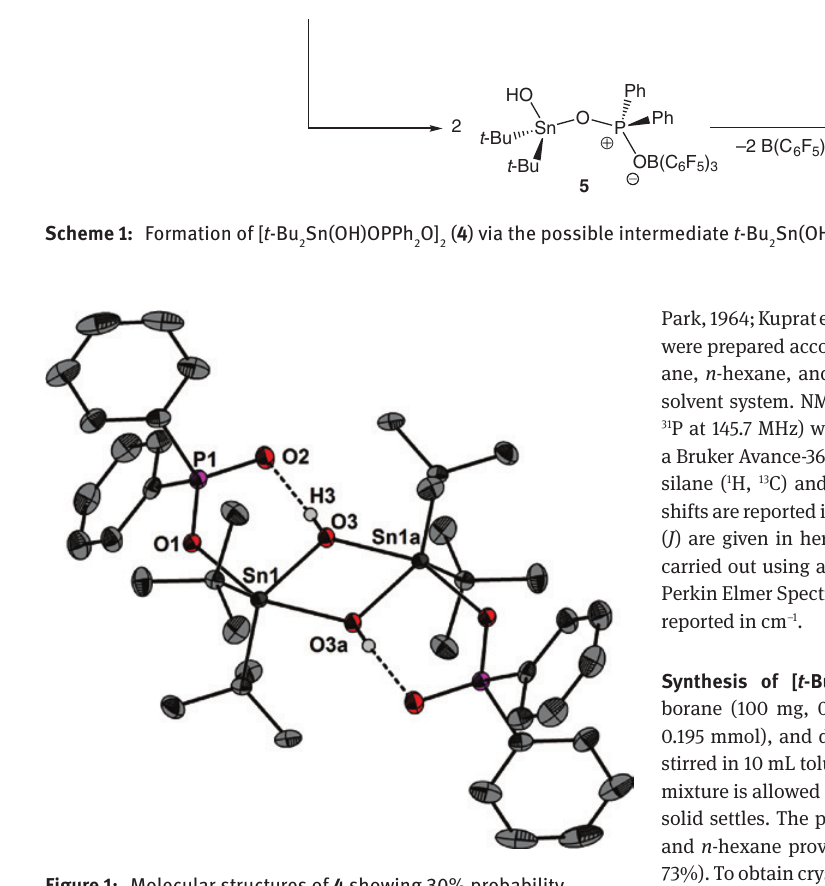
Figure 1: Molecular structures of 4 showing 30% probability ellipsoids and the crystallographic numbering scheme. Selected bond parameters of 4 [Å, ° ]: P1-O1 1.534(2), P1-O2 1.500(2), Sn1-O1 2.159(2), Sn1-O3 2.039(2), O2-O3 2.595(3), P1-O1-Sn1